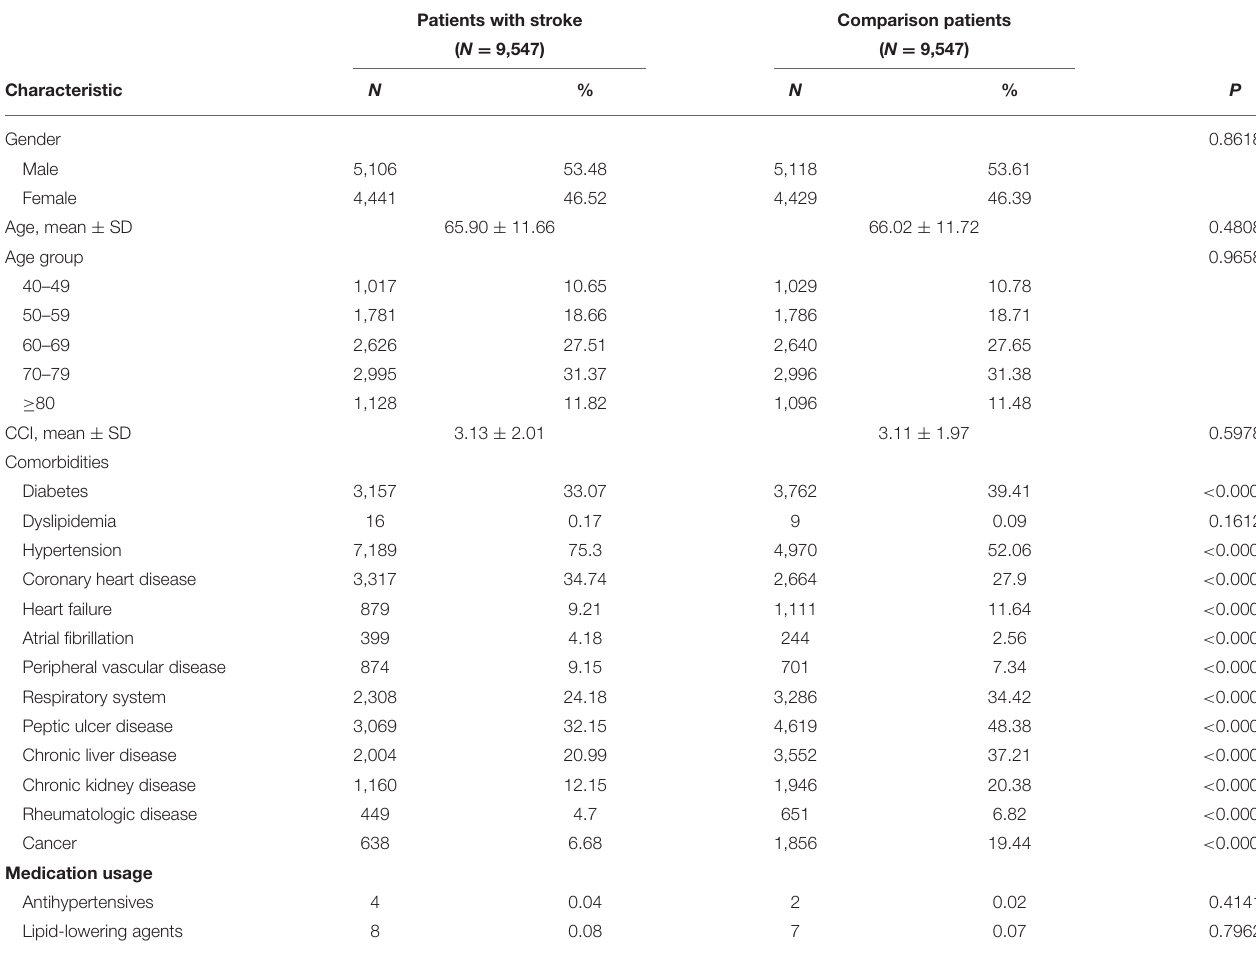
TABLE 1 | Geographic characteristics and comorbidities of the patients with stroke and comparison patients. Patients with stroke Comparison